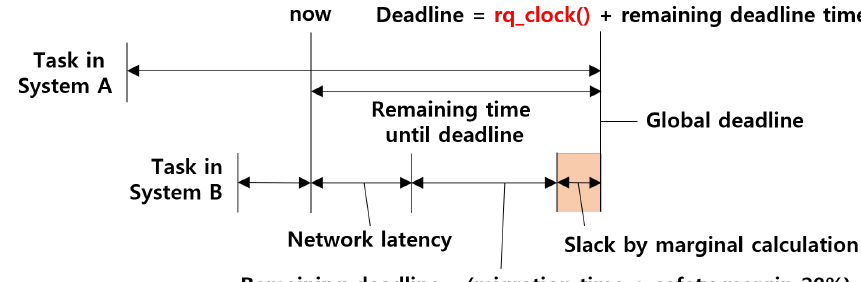
Table 5. Network latency was measured using the ping command. From the results, it can be observed that using WiFi-direct provides a more stable network latency than the router, which enables bandwidth reservation only for connected systems. It is also better to use a combination of WiFi-direct and a network module. In our experiment, the NEXT- 1302WBTA network module was used, resulting in a 1.8 times faster communication on average. In total, network responsiveness highly depends on the specifications of the hardware devices and bandwidth reservations. Real-time bounds can be extended through network bandwidth. Some previous studies bind network latency, such as TTEthernet [15], to TSN [16].